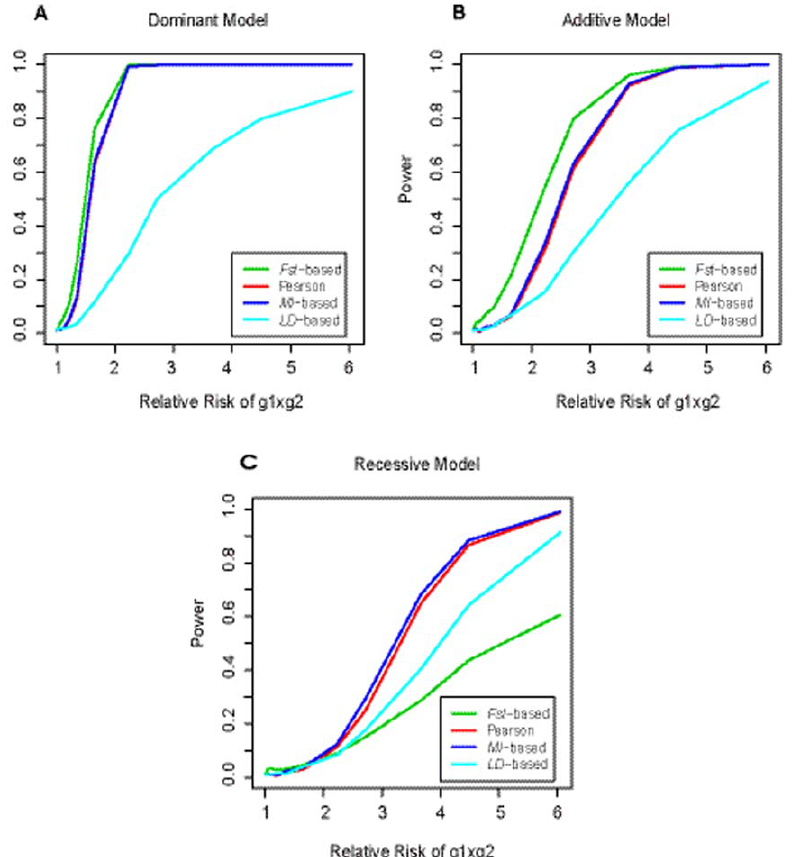
Figure 4. Power of four statistics under three different models when the disease allele frequencies at the two loci are high. The disease prevalence is assumed to be 1%. The disease allele frequencies at the two loci (g1 and g2) are 0.3 and 0.8, respectively. The power, at significance level a of 0.05, is obtained based on simulations of 500 cases and 500 controls. The green, red, blue, and cyan lines are the power of Fst based statistic, Pearson’s Chi-square statistic, MI based statistic, and LD based statistic, respectively. Three plots (A, B, C) correspond to the dominant model, the additive model and the recessive model, respectively.